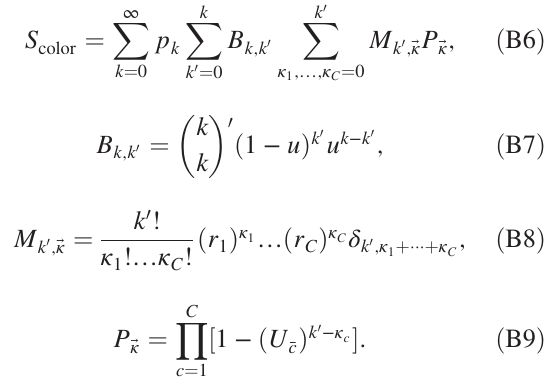
using the equality g